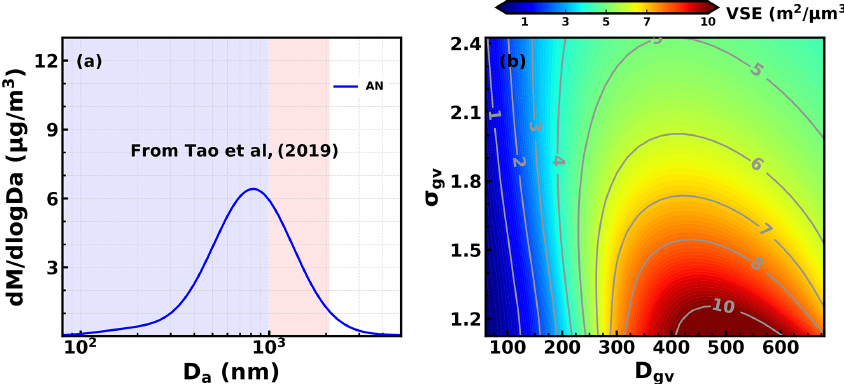
Figure 3. (a) AN mass size distributions derived by Tao et al. (2019) based on size-resolved filter measurements, Da is the aerodynamic diameter. (b) Simulated aerosol volume scattering efficiency (VSE) under different volume size distributions through varying volume geo- metric mean D gv and standard deviation σ gv of lognormal size distributions. The blue shaded area corresponds to PM 1 , and the pink shaded area corresponds to PM 1 − 2 . 1 .